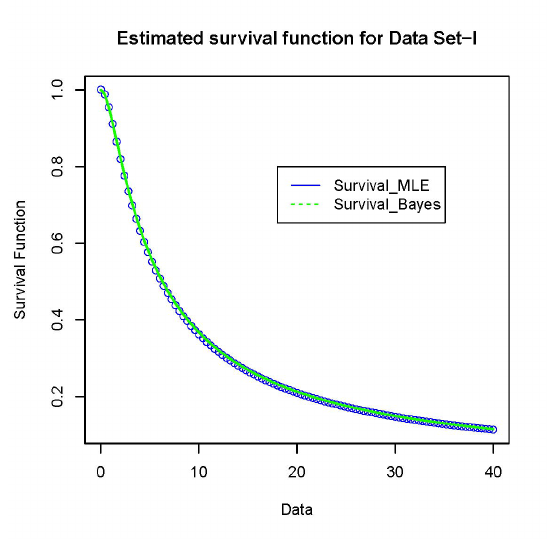
Figure 3 – Estimated survival function plot for the data